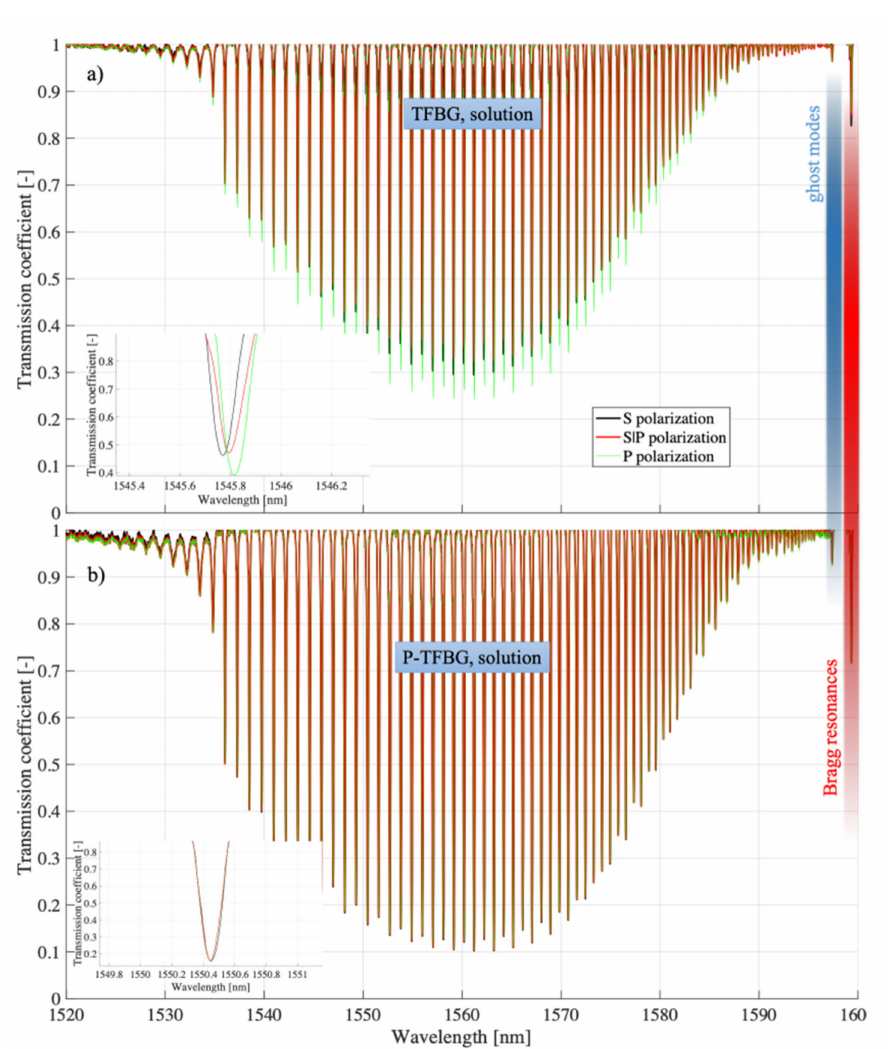
Figure 16. Spectral characteristics measured in solution for three polarization states of the input light of ( a ) TFBG, ( b ) P-TFBG